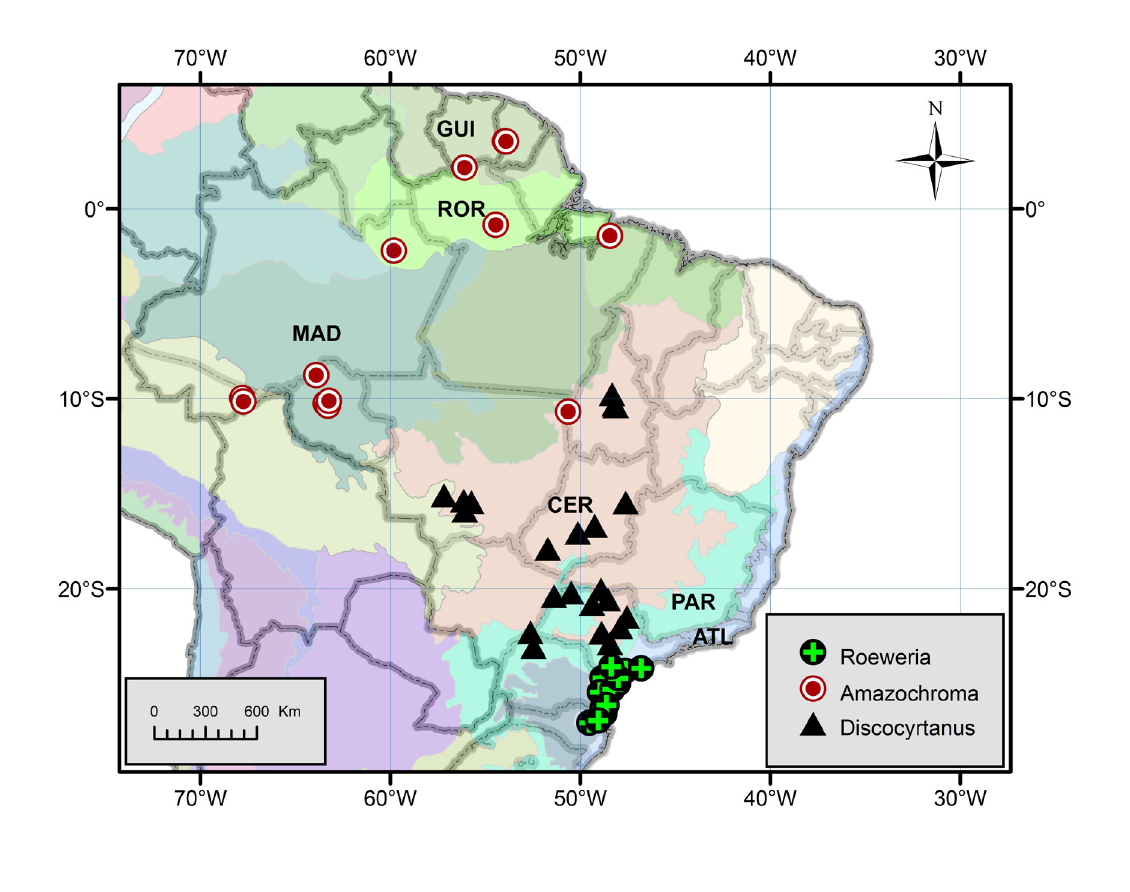
Fig. 11. Brazil and Guianas, showing parapatric distribution of the genera of Roeweriinae subfam. nov. Shaded areas in the background are Morrone's regionalization of the Neotropics (“provinces”; Morrone, 2014). ATL = Atlantic province; CER = Cerrado province; GUI = Guianan Lowlands province; MAD = Madeira province; PAR = Paraná Forest province; ROR = Roraima